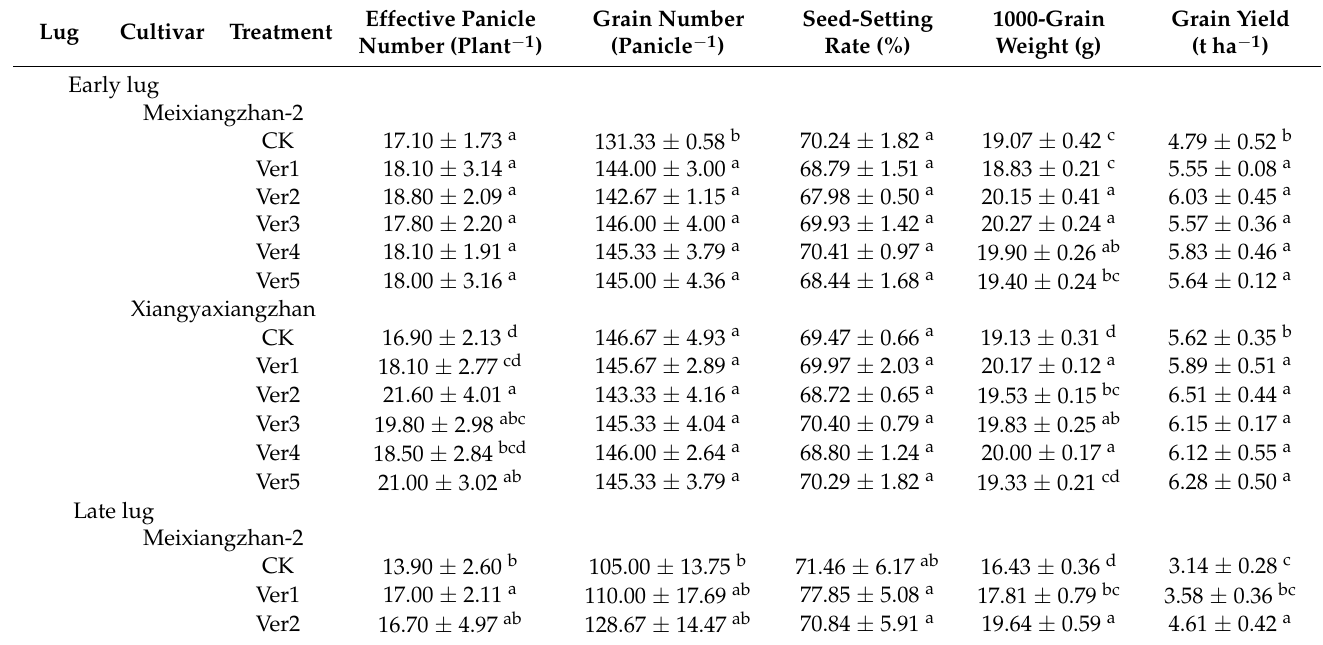
Table 1. Effects of different vermicompost rates on yield formation of fragrant rice cultivars. Lug Cultivar